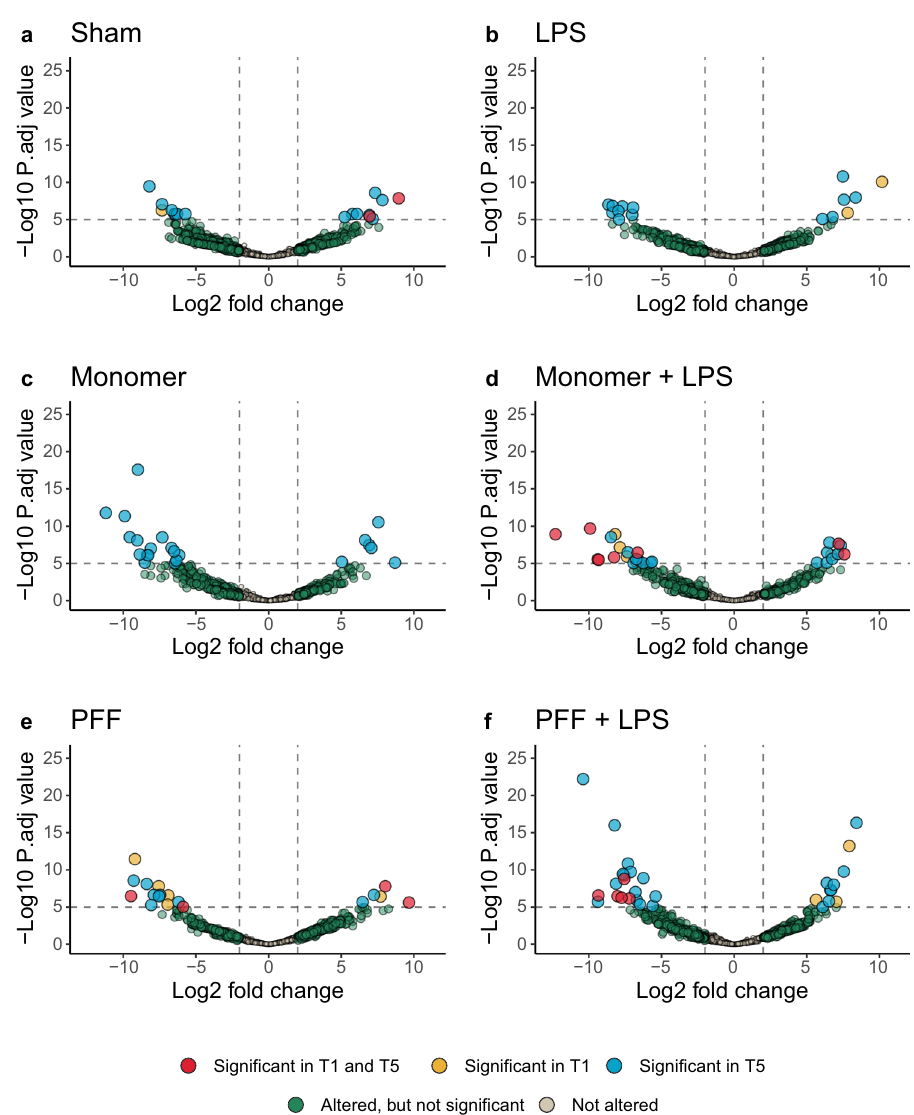
Fig. 5 Volcano plots showing a differential abundance of rat faecal viruses and viral clusters at 1 month (T1) and 5 months (T5) relative to the study ’ s baseline. Differential abundance changes in faecal viruses and viral clusters of rats following the treatment conditions; a Sham, b LPS, c α -syn monomer, d α -syn monomer plus LPS, e α -syn PFF and f α -syn PFF plus LPS. The vertical dashed lines of each panel indicate log2 fold changes equivalent to + 2 or − 2, while the horizontal dashed line denotes a Bonferroni adjusted p value signi fi cance of 1E-05. The axis values of all panels are scaled